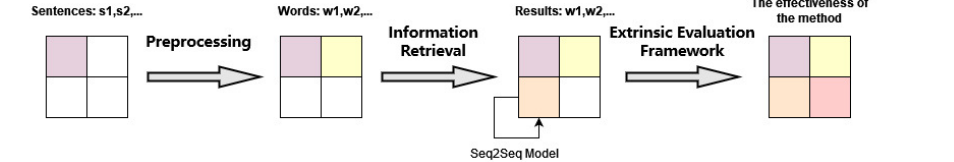
Figure 3. Overall view of the